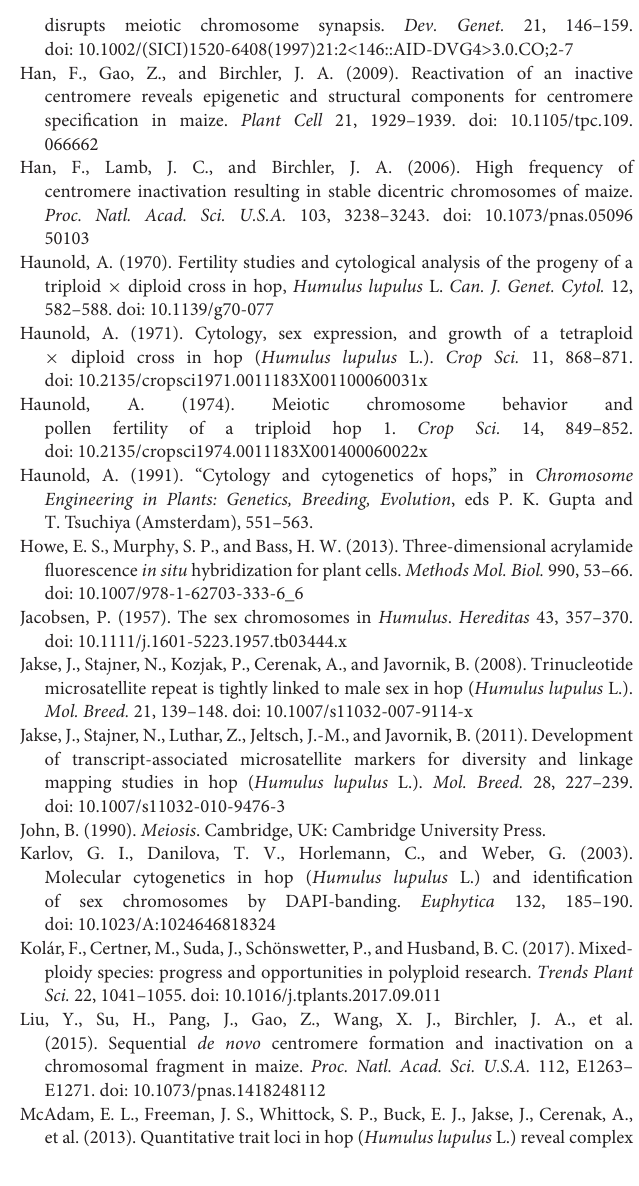
Figure S1 | Plant 255A highlighting the lone 5S rDNA-bearing chromosome at diakinesis. Projections of 3D FISH datasets were produced as described in